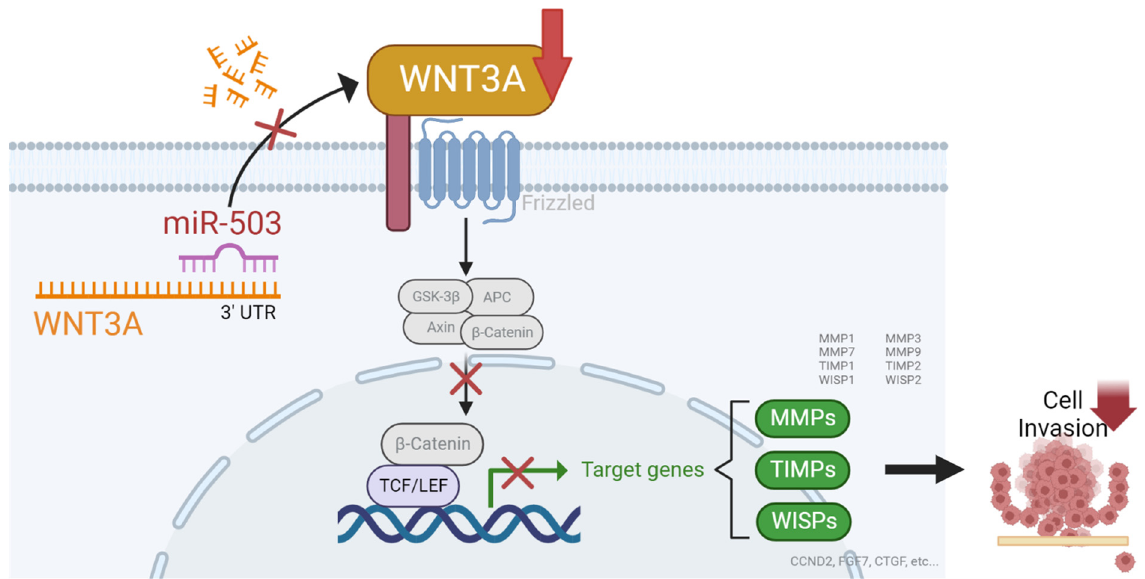
Figure 5. Summary figure of the miRNA-503/WNT3A pathway in HNC. Normally, activated WNT signaling induces β -Catenin translocation to the nucleus, promoting the transcription of MMPs, TIMPS, WISPs, and other invasion-associated genes. However, the overexpression of miR-503 subdues the activity of the WNT signaling pathway through WNT3A suppression, decreasing transcriptional activity, which results in the inhibition of HNC invasion.